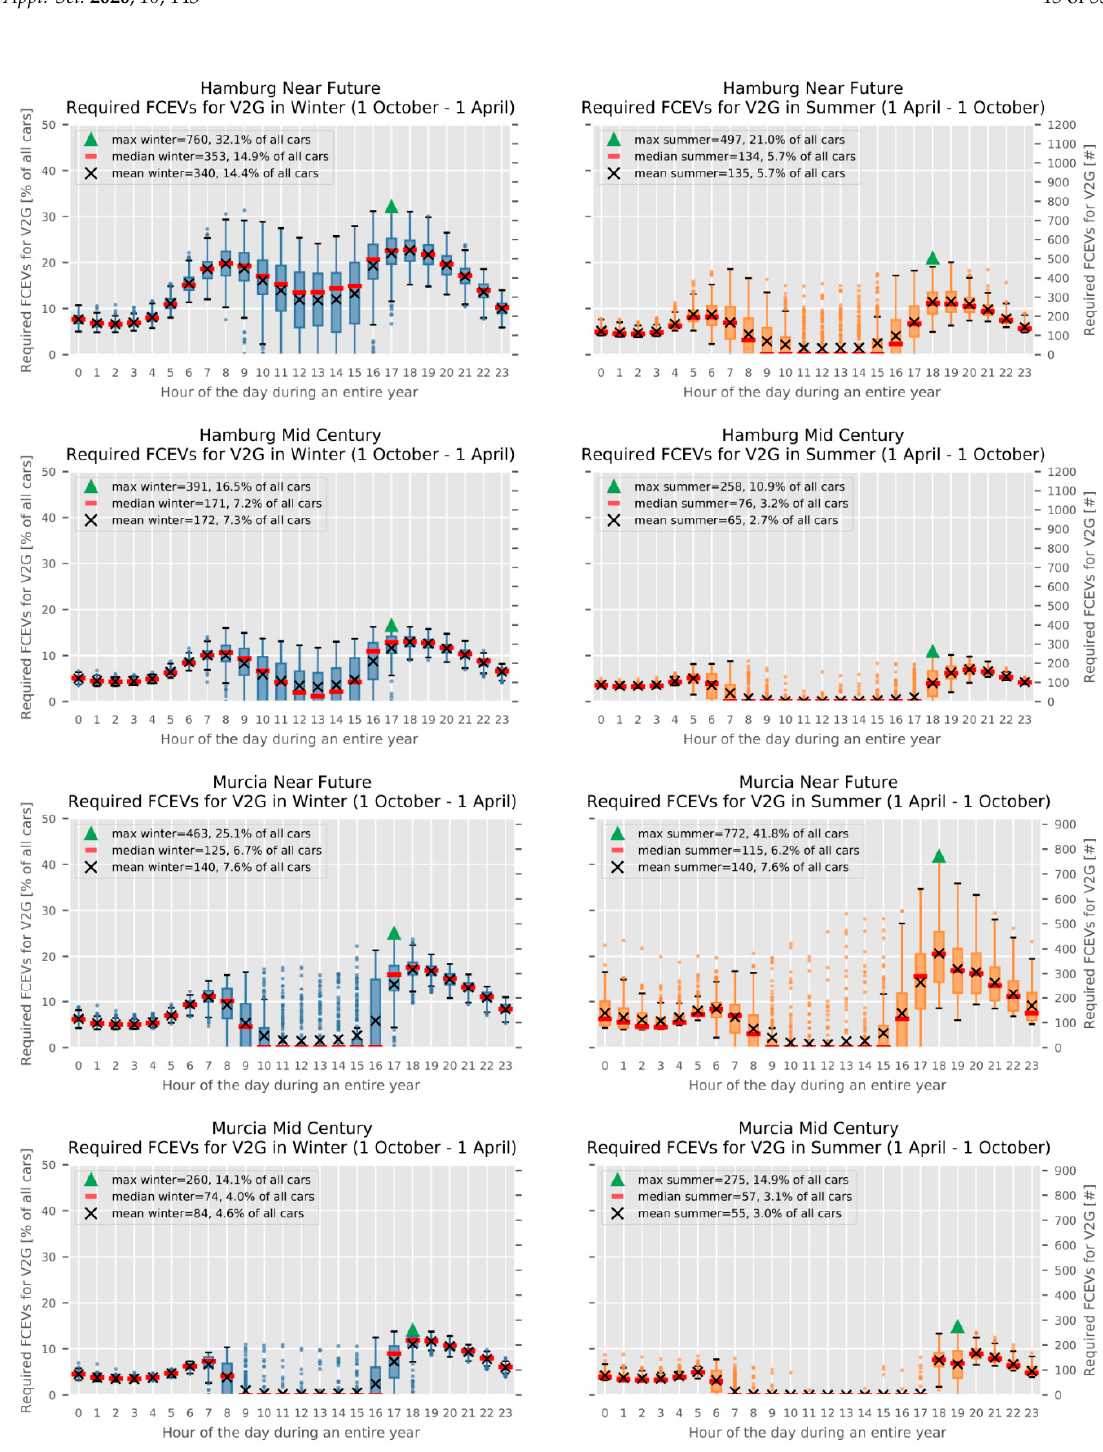
Figure 6. Boxplots showing the hourly average FCEVs needed for producing V2G electricity (# left y -axis, % of all cars right y -axis) throughout the day during the colder winter period (in blue, left, 1 October–31 March) and the warmer “summer” period (in orange, right, 1 April–30 September) in the Near Future and Mid Century scenarios for, respectively, Hamburg and Murcia. The black crosses represent the mean values, the red lines represent the medians, and the green triangles represent the maxima. Based on a normal distribution, the bars represent the interquartile range, IQR, the difference between the first and third quartiles (Q1 and Q3), approximately 50%. The upper and lower whiskers represent the data points within the ranges [Q1–(Q1-1.5×IQR)] and [Q3+(Q3+1.5×IQR)], approximately 44%. Dots indicate outliers, outside aforementioned ranges, the remaining approx. 1%.